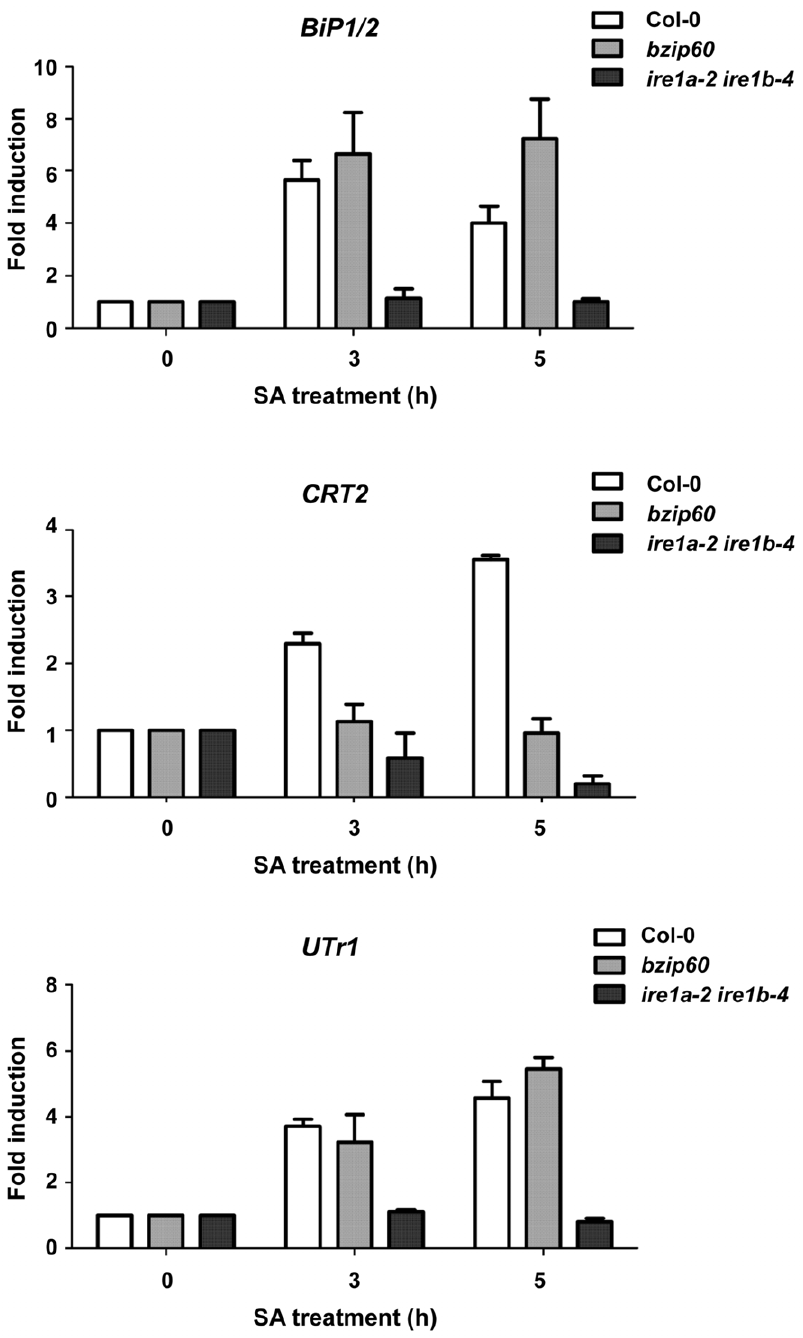
Figure 7. SA-induced up-regulation of UPR responding genes is altered in ire1 and bzip60 mutants. Plants (Col-0, bzip60 and ire1a-2 ire1b-4 ) were treated with SA for 3 and 5 hours. RNA was extracted and quantitative PCR was performed for BiP1/2, calreticulin 2 (CRT2) and the UDP- glucose transporter (UTr1). The results were normalized against a housekeeping gene (putative clathrin adaptor). Experiment was performed at least three times with similar results.